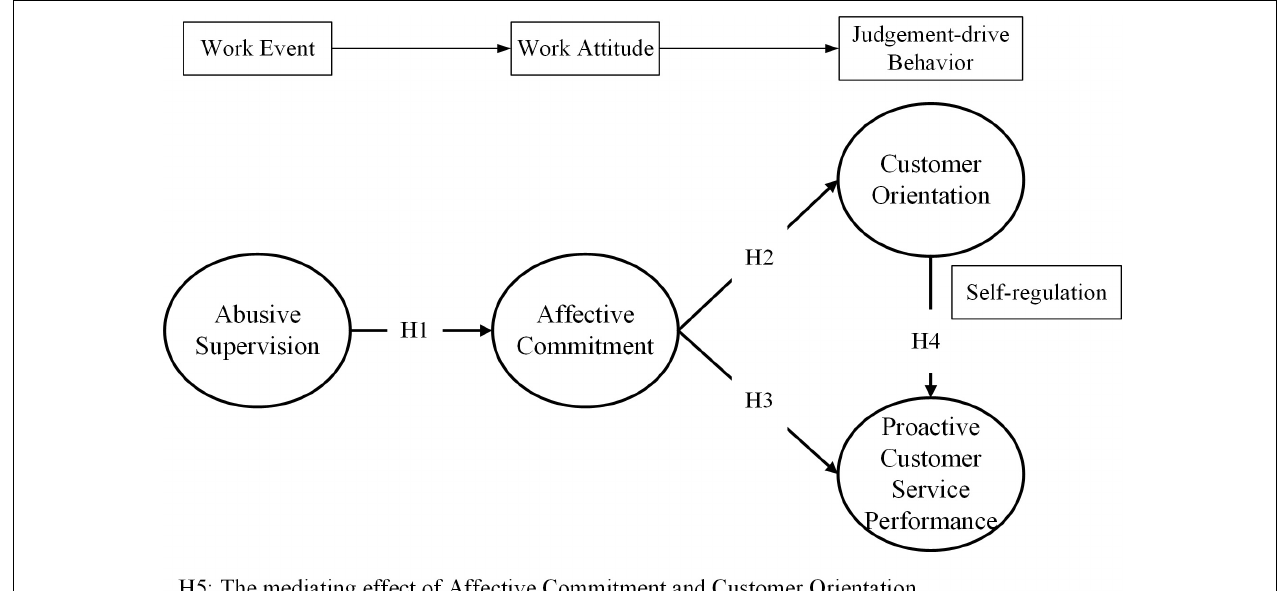
FIGURE 1 | Theoretical framework and proposed research